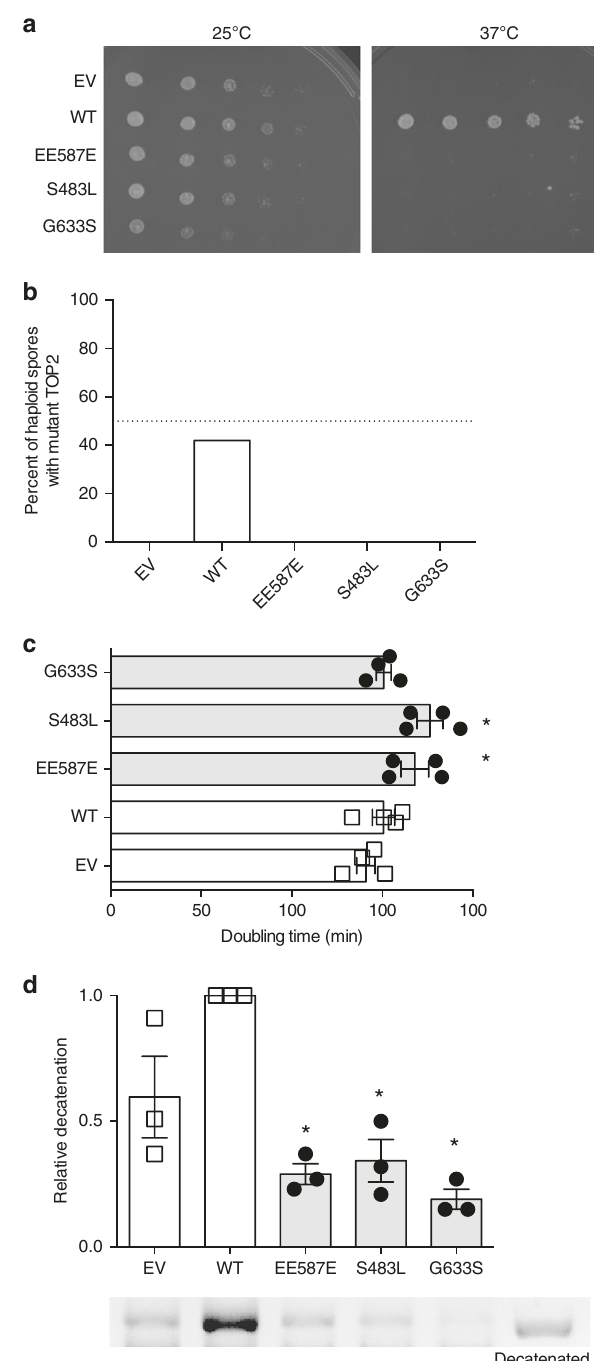
Fig. 2 Patient mutations have a dominant negative phenotype in